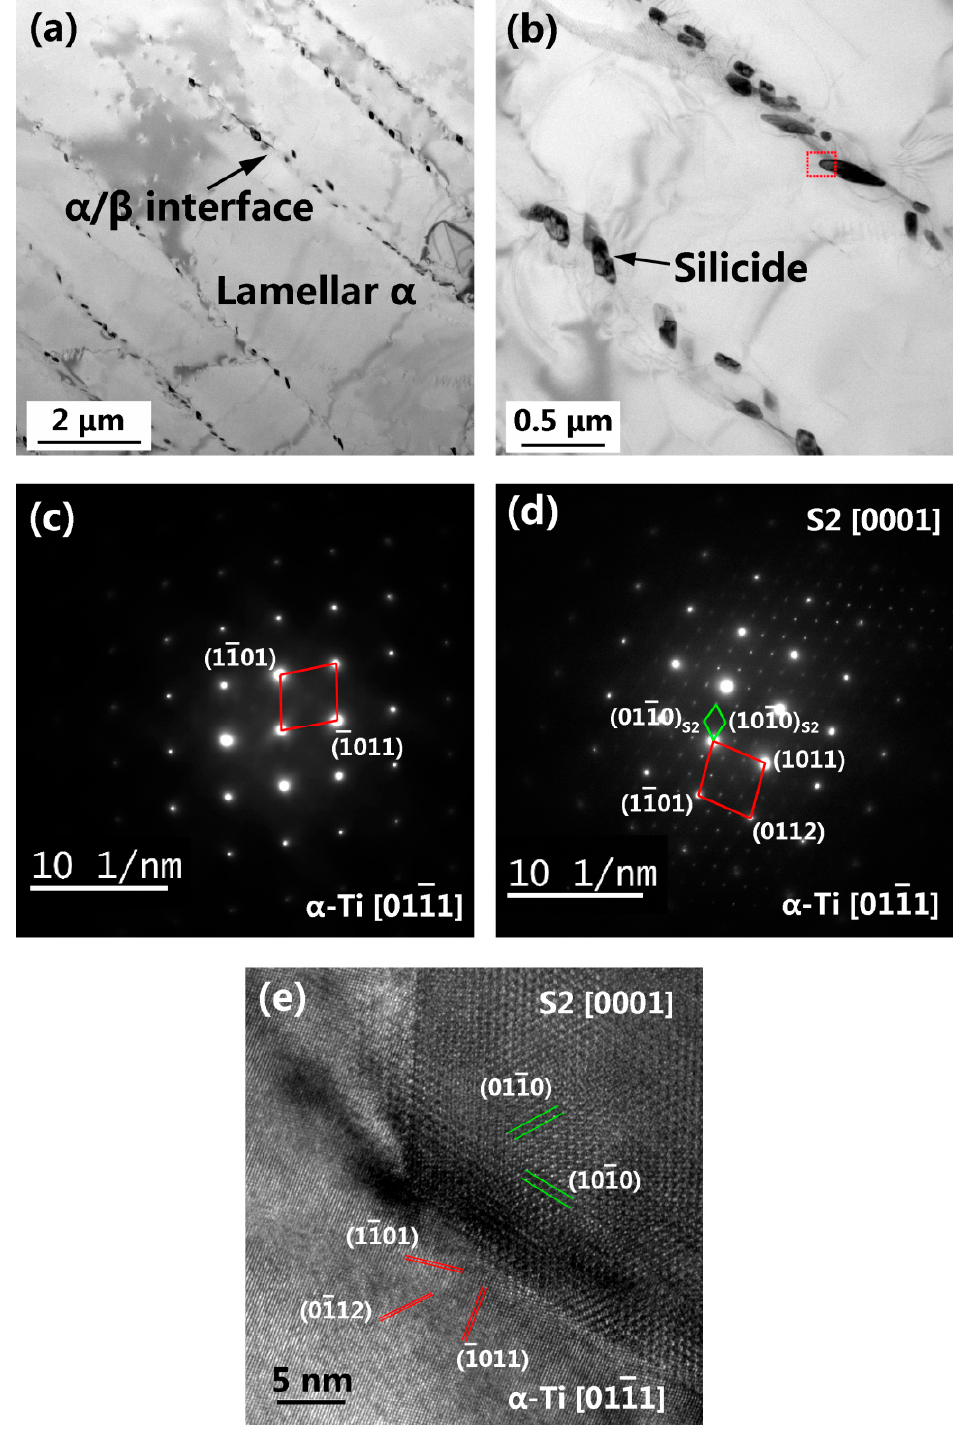
Figure 6. STEM images of the as-built Ti60 alloy: lamellar α ( a ) and silicides ( b ); SADPs of the lamellar α ( c ) and silicides (marked as S2) ( d ), and the HRTEM image of the α -Ti/silicide interface ( e ).